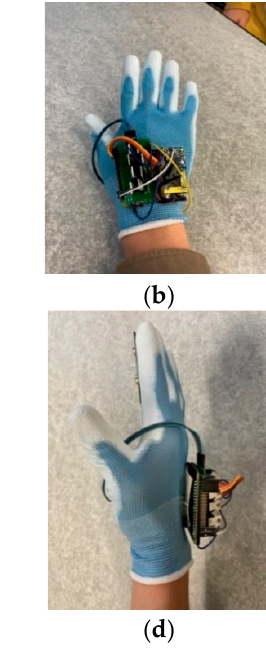
Figure 14. Two kinds of tactile display attached to the glove. ( a ) Tactile display 1 attached to the palm of the gloves. ( b ) Control circuits attached to back of gloves. ( c ) Tactile display 2 attached to the palm of the gloves. ( d ) Control circuits attached to back of gloves.